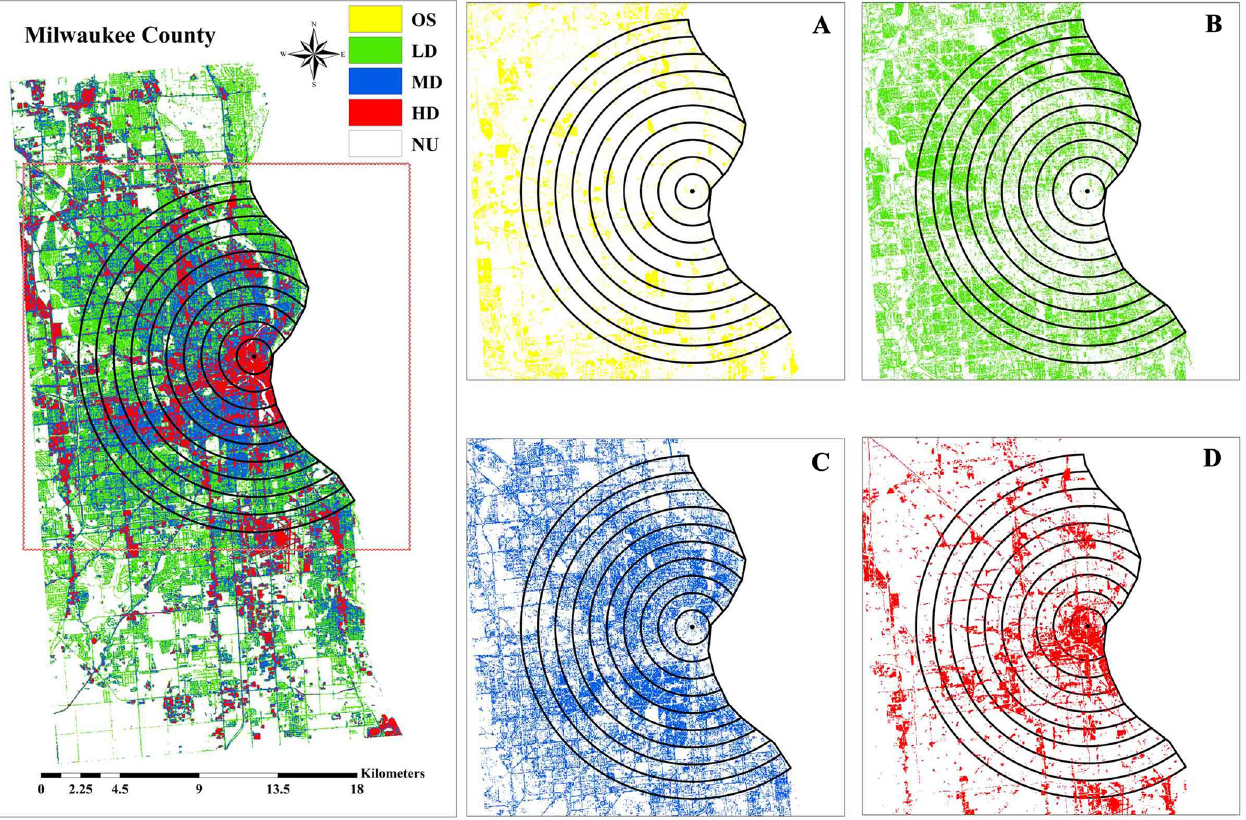
Fig 5. Urban density classes within 1–10 km buffers in Milwaukee County in 2011. (A) Open-space areas variation within 1–10 km buffers. (B) Low-density areas variation within 1–10 km buffers. (C) Medium-density areas variation within 1–10 km buffers. (D) High-density areas variation within 1–10 km buffers. NU represented non-urban